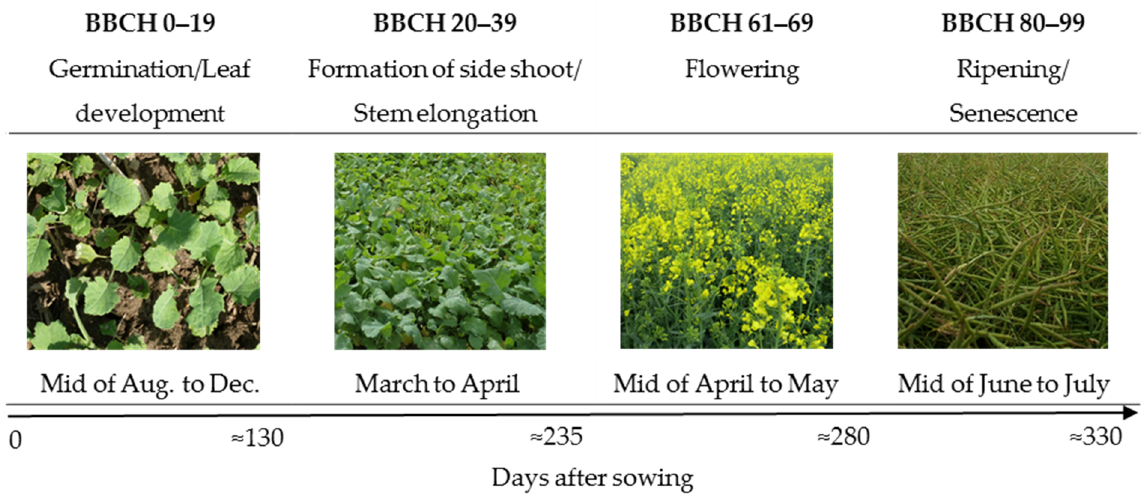
Figure 2. Winter oilseed rape-growth stages calendar in Germany .